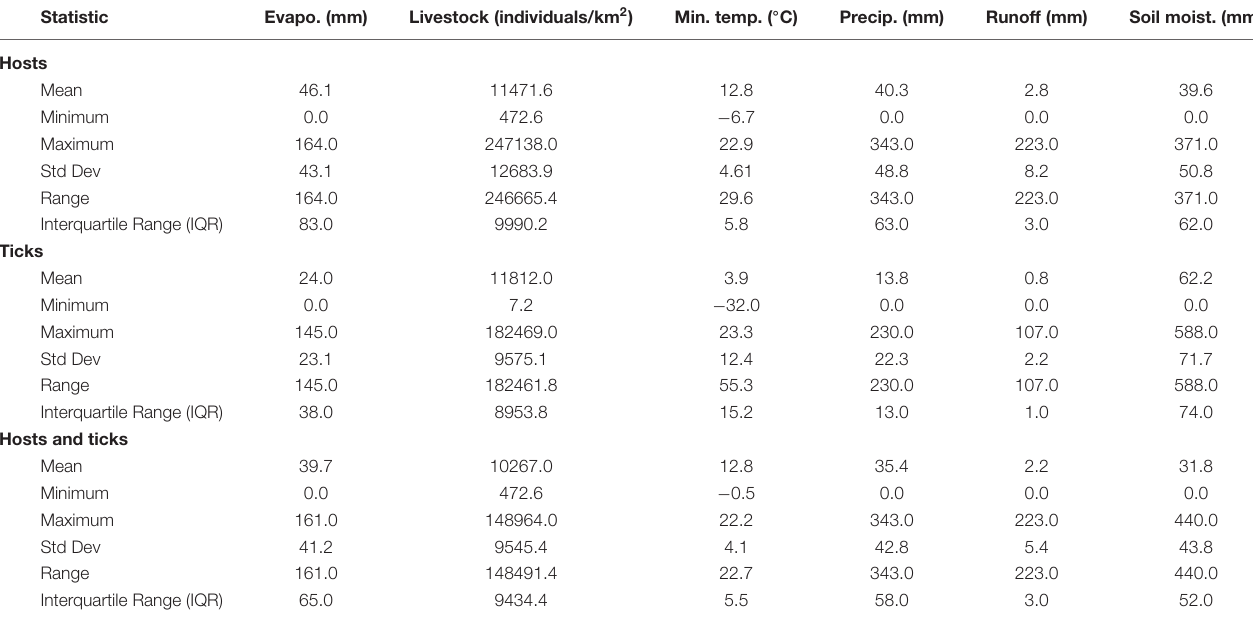
TABLE 2 | Environmental preference of hosts, ticks, and hosts & ticks based on their potential distributions. Statistic Evapo. (mm) Livestock (individuals/km 2 ) Min. temp. ( ◦ C) Precip.